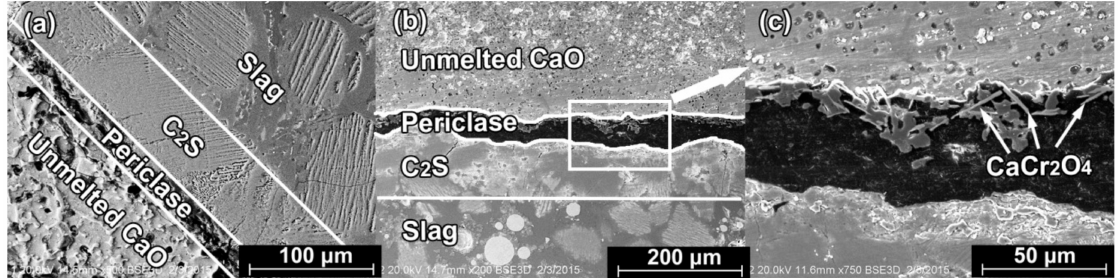
Figure 7. SEM images of interface zone between ( a ) CaO lump and S4; ( b ) and ( c ) CaO lump and